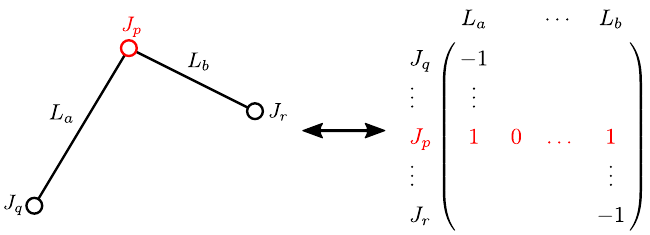
Figure 7. A two-link chain described on LJ-matrix.